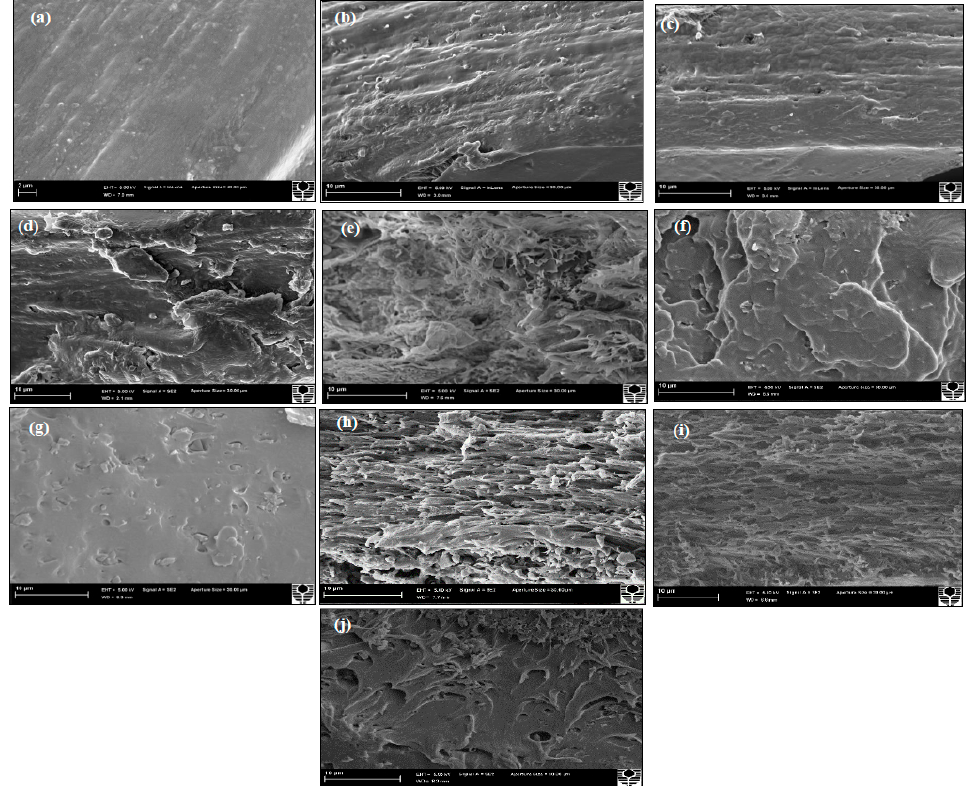
Figure 8. SEM micrographs of tensile fracture surfaces: ( a ) PVA, ( b ) PVA/3 wt % HNT SEM micrographs of tensile fracture surfaces: ( a ) PVA, ( b ) PVA / 3 wt % HNT bionanocomposites, ( c ) PVA / 5 wt % HNT bionanocomposites, ( d ) PVA / 10 wt % HNT